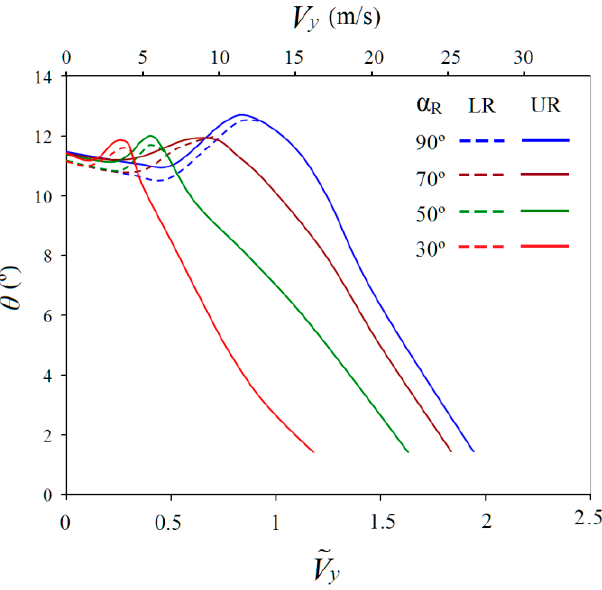
Figure 4. Calculated dependencies of UR and LR blade pitch angles ( C T Σ = 0.015 =